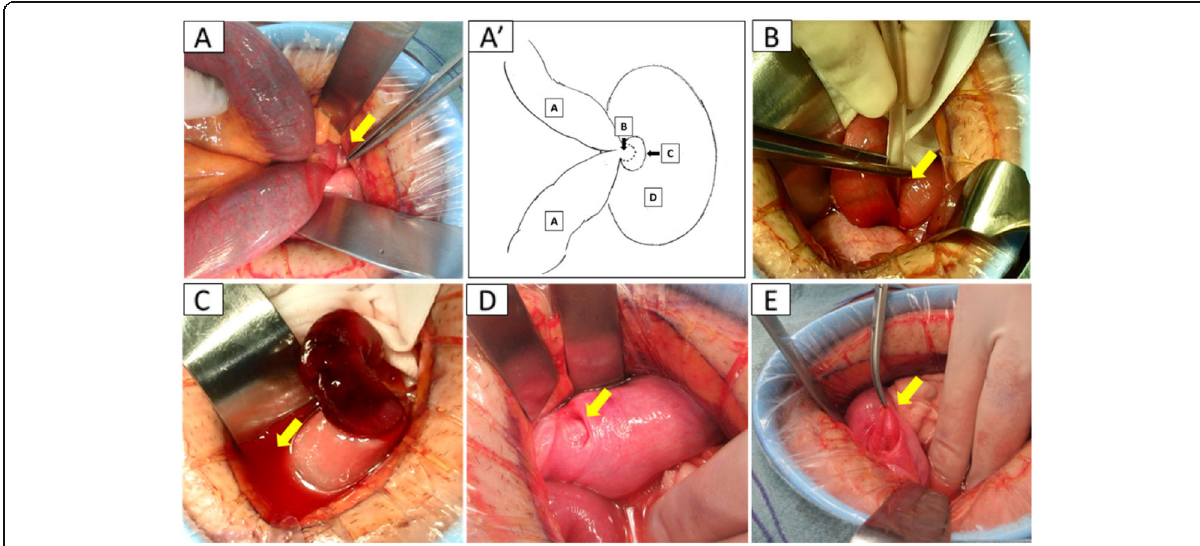
Fig. 2 Intraoperative findings. (2A) The bladder left wall was inverted, wherein the small intestine was incarcerated as Richter ’ s hernia (arrow). (2A ’ ) Schema, A; small intestine, B; incarcerated small intestine, C; bladder diverticulum, D; bladder. (2B) The water pressure method was used to reposition the intestine (arrow). (2C) Although the small intestine exhibited a dark red color and edema, there was no manifested necrosis or perforations. After releasing the incarceration, bloody ascites in the gap flowed into the abdominal cavity (arrow). (2D) Inverted bladder diverticulum (arrow). (2E) Eversion of the inverted bladder diverticulum (arrow)